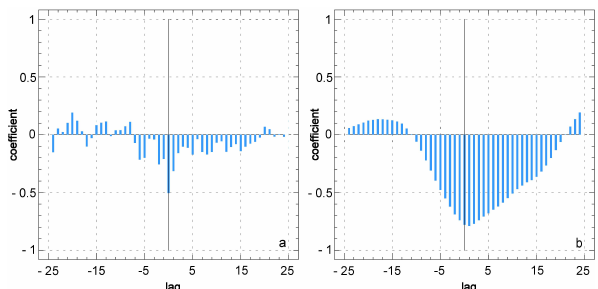
Fig. 8. Cross-correlation analysis between the NAOI and the MADI, carried out on (a) the original time series and (b) the 11-yr moving averages.